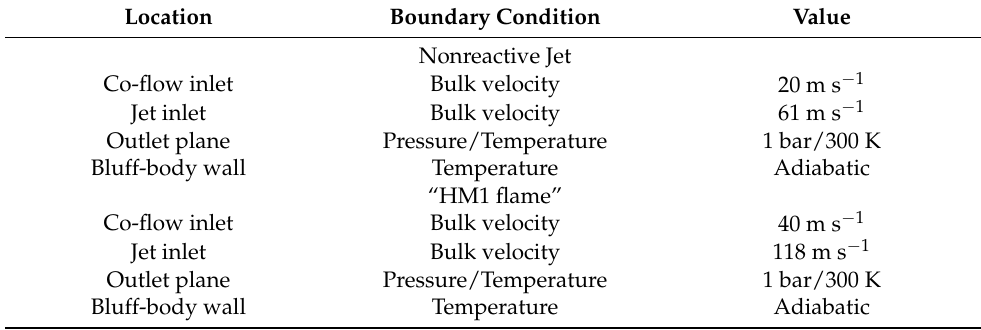
Table 1. Boundary